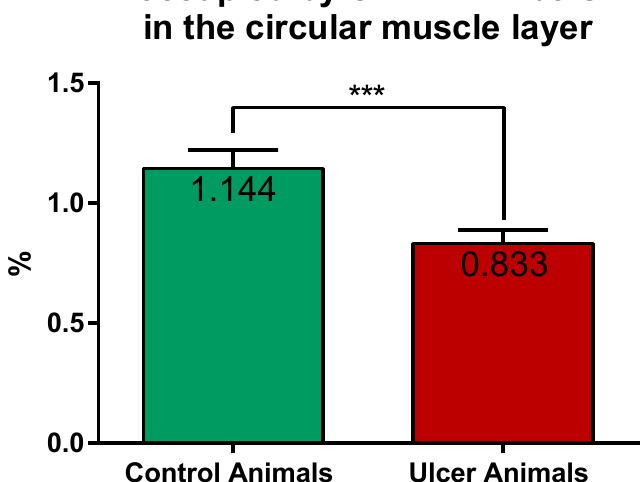
Figure 7. Graph showing the percentage of surface area (in the field of view) occupied by CART- immunofluorescent nerve fibers located in the circular muscle layer in the control and ulcer pigs. The value decreased in animals with ulcers. (***) p value = 0.0006.